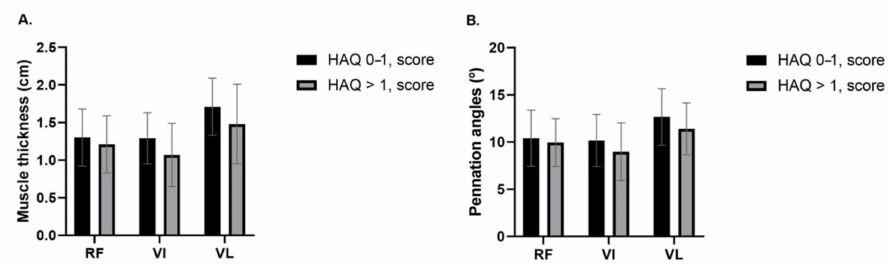
Figure 3. ( A ) Muscle thickness of patients according to the level of physical function assessed by HAQ. ( B ) Pennation angle of patients with low physical function assessed by HAQ. RF: rectus femoris; VI: vastus intermedius; VL: vastus lateralis; cm: centimeters; ◦ : degrees; HAQ: Health Assessment Questionnaire. Data presented as mean ±